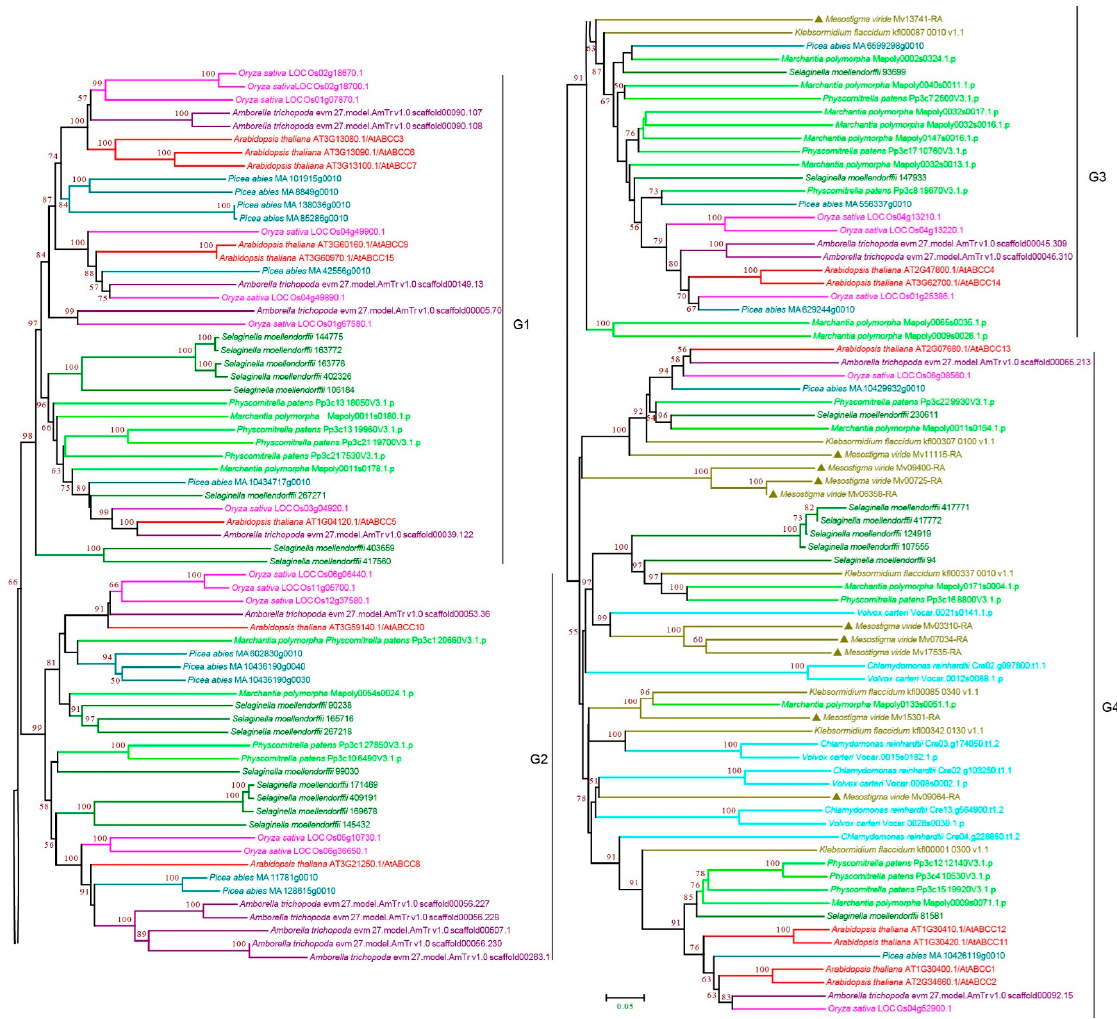
Figure 4. Phylogenetic analysis of ABCC subfamily proteins from 11 evolutionarily representative plant species. A neighbor-joining (NJ) tree was generated using MEGA7 with 1000 bootstrap repli- cates, and bootstrap values >50% are shown on the branches. The M. viride proteins are highlighted by